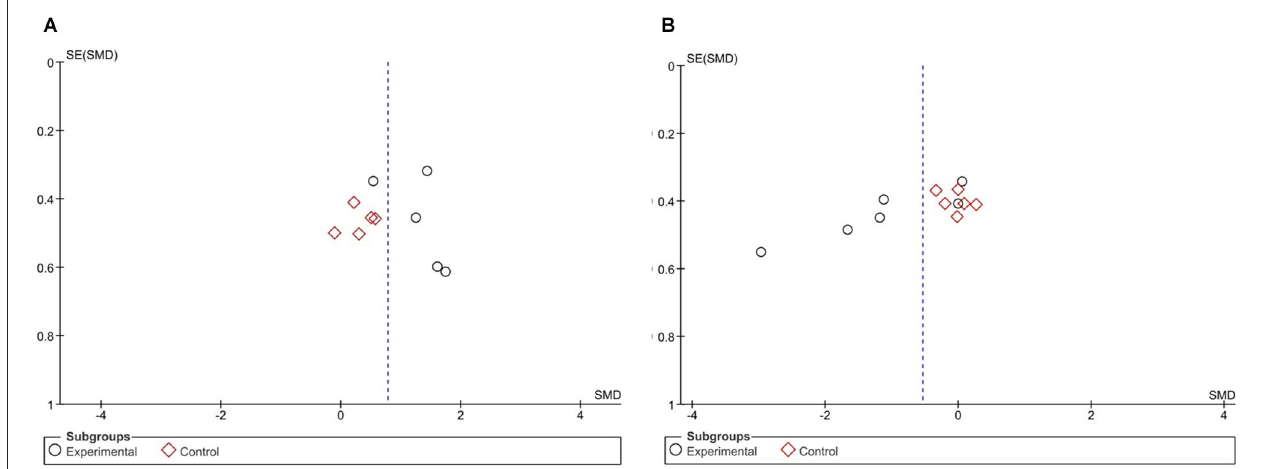
FIGURE 5 | (A,B) Risk of bias from studies on the effect of NFB on reaction time on sports performance ( Figure 4A ) and cognitive skills ( Figure 4B ). Created using Software Review Manager